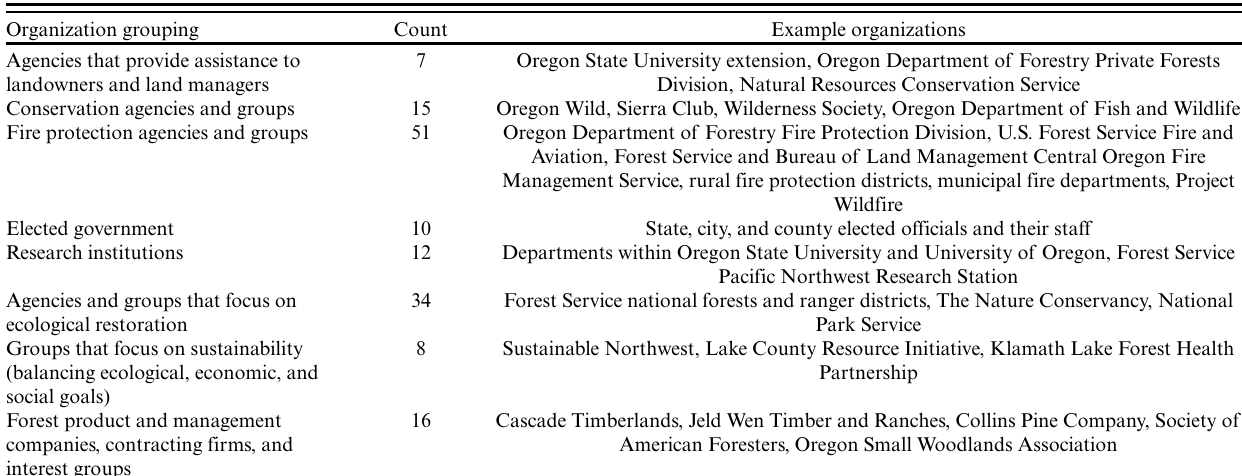
Table 2. Typology and examples of institutions, social networks, and collaboratives currently operating in central and south-central Oregon, USA. Information is based on interviews with various stakeholders (P. Fischer, unpublished data